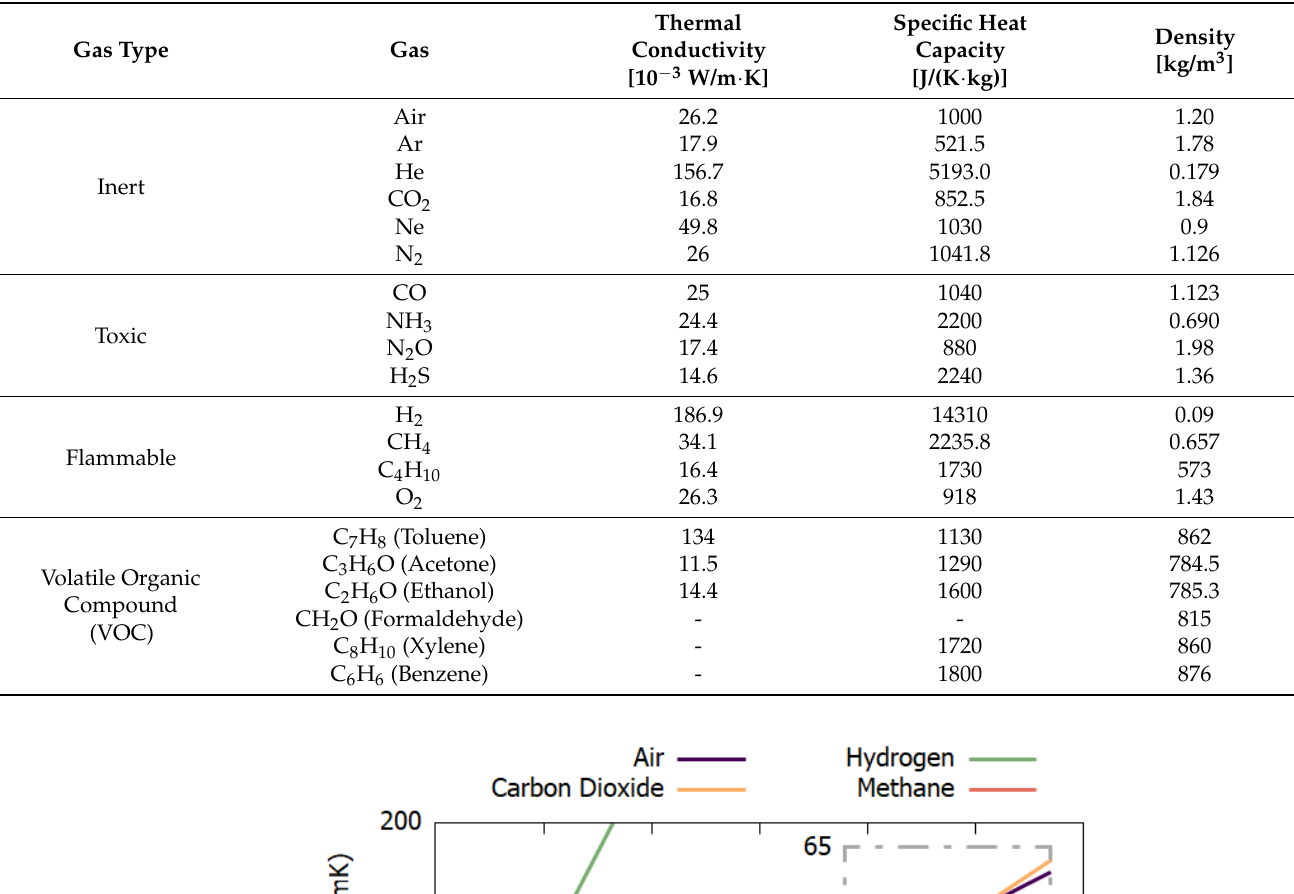
Table 1. A table displaying several gases that are often measured, monitored and controlled in industry with their relevant thermal parameters. The values refer to pressure of 1 bar and temperature of 300 K.